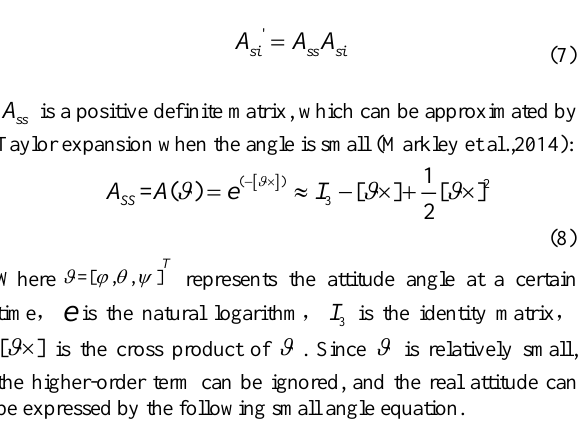
Figure 2 . The scheme of image jitter